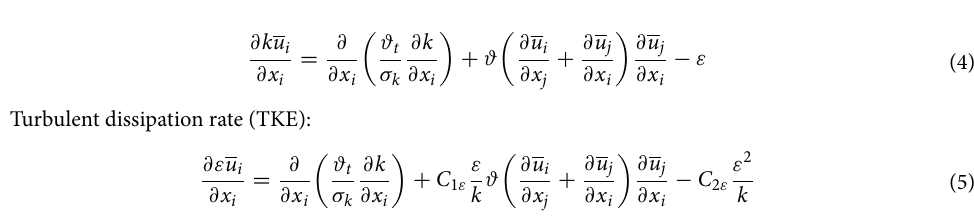
Figure 8. Field measurement of wind velocity on profiles perpendicular to